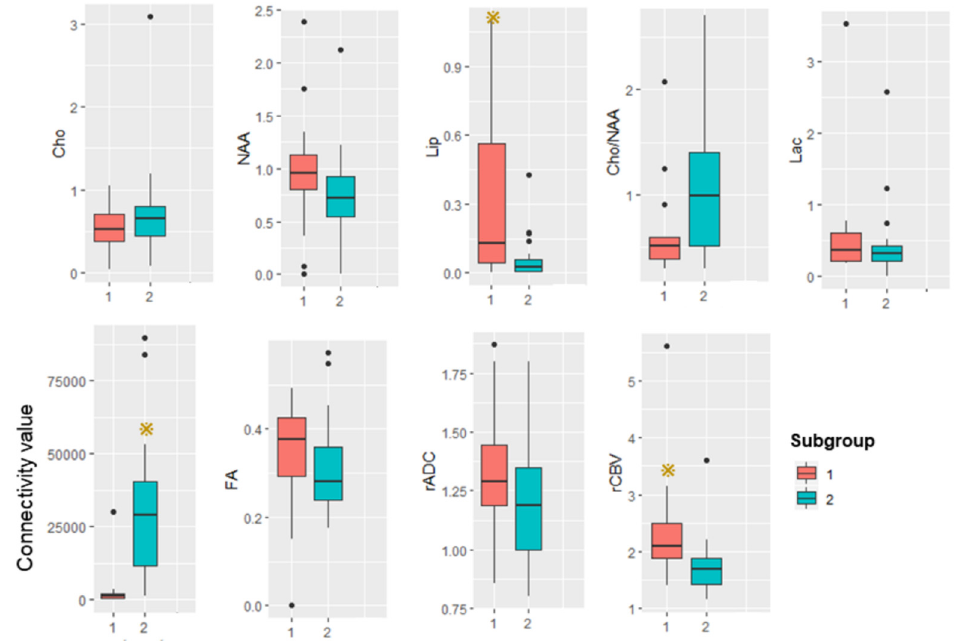
Figure 6. Box plot summarizing advanced MRI measurements in the two subgroups. Yellow star represents p is less than 0.05.